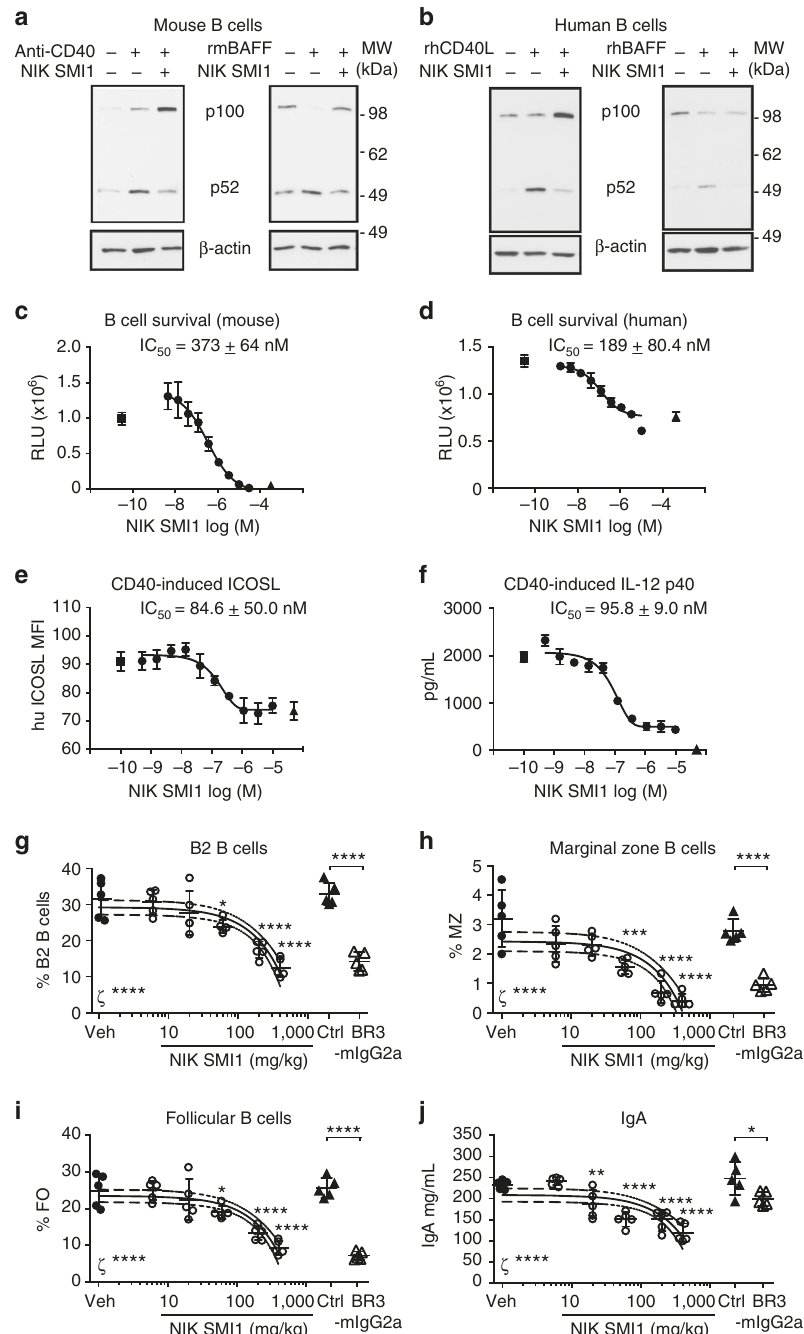
Fig. 2 NIK SMI1 inhibits BAFF and CD40 induced signaling in B cells and IgA production. a , b Inhibition of anti-CD40 or BAFF induced p52 processing in murine ( a ) or human ( b ) B cells as analyzed by western blot. c , d Inhibition of BAFF induced survival of murine ( c ) or human ( d ) B cells in vitro. e Inhibition of rhCD40L induced ICOSL expression on human B cells isolated from PBMC. ICOSL MFI was determined by FACS analysis. f Inhibition of IL-12p40 production from human monocyte derived DC stimulated with rhCD40L. Triangles, unstimulated + DMSO; squares, BAFF or rhCD40L+ DMSO; circles, BAFF or rhCD40L stimulation with NIK SMI1 titration. A representative curve is shown in each case, and IC 50 values represent mean ± standard deviation of 2 ( c ), 3 ( d ), 4 ( e ), and 3 ( f ) experiments. ( g – j ) Dose-dependent in vivo effect of NIK SMI1 on B cell subsets and serum IgA. Frequencies of B2 B cells (CD5 - B220 + ) ( g ), marginal zone B cells (B220 + CD21 hi CD23 low ) ( h ), follicular B cells (B220 + CD21 low CD23 + ) ( i ), and concentration of serum IgA ( j ) are shown. Representative data of three independent experiments are shown. Data represented as mean ± standard deviation of 4 – 5 mice per group and linear regression curve (solid line) and 95% con fi dence interval curves (dashed lines) are drawn demonstrating statistically signi fi cant ( ζ ) negative slope and reduction with increasing NIK SMI1 dose. Statistics: Vehicle vs. NIK SMI1 doses, One-way ANOVA with Dunnett ’ s test for multiple comparisons. Isotype control vs. BR3-mIgG2a, unpaired t -test with Welch ’ s correction. * p < 0.05, ** p < 0.01, *** p < 0.001, **** p < 0.0001; ns not signi fi